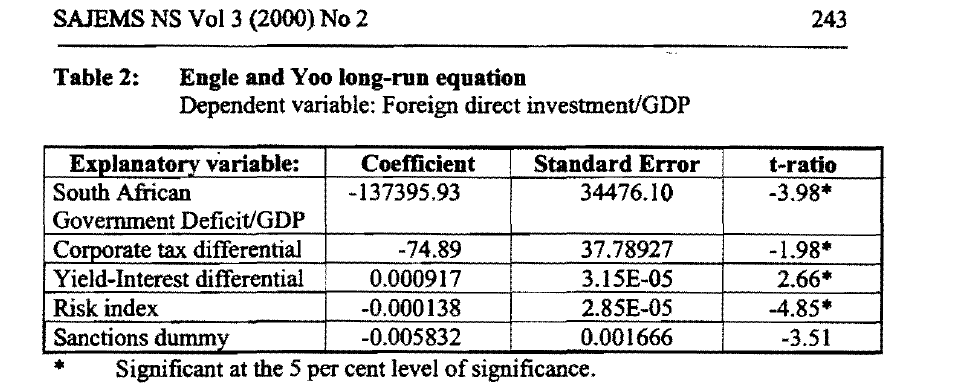
Table 2: Engle and Yoo long-run